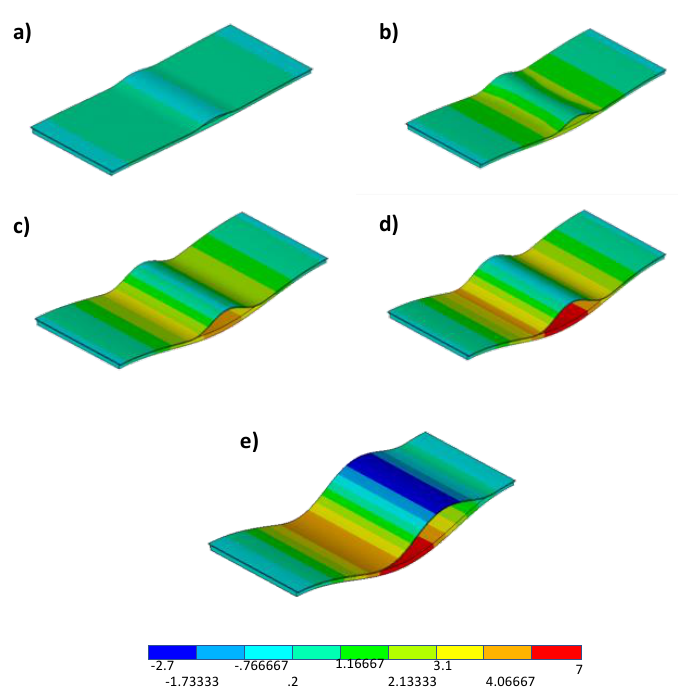
Figure 21. Numerical out-of-plane displacement contour plot for toughened material (units in mm) at ( a ) 0.3 mm applied displacement, ( b ) 0.4 mm applied displacement, ( c ) 0.55625 mm applied displacement, ( d ) 0.73125 mm applied displacement, and ( e ) 1.18 mm applied displacement.